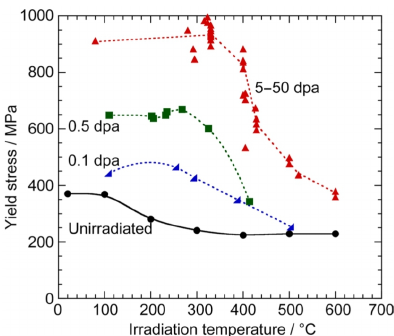
Figure 15. Yield strength of V alloy as a function of temperature and irradiation dose. Reprinted from Ref. [95]. Credit c (cid:13) Elsevier,